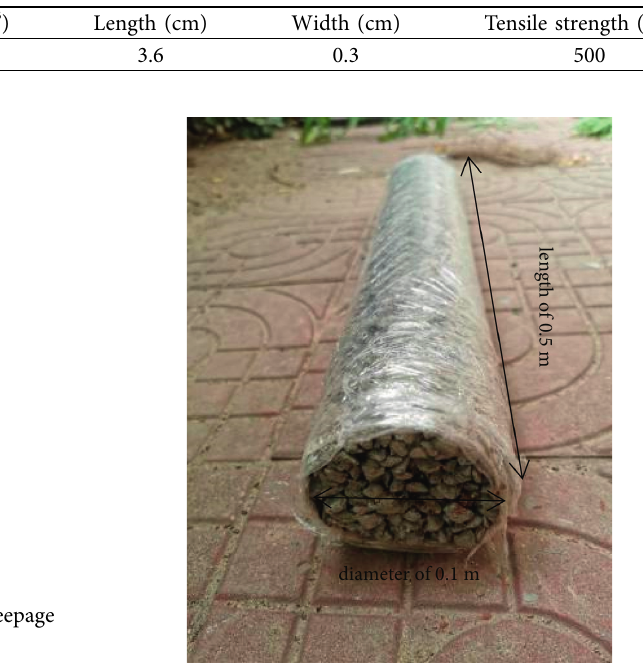
Figure 2: Seepage well wrapped in plastic film.